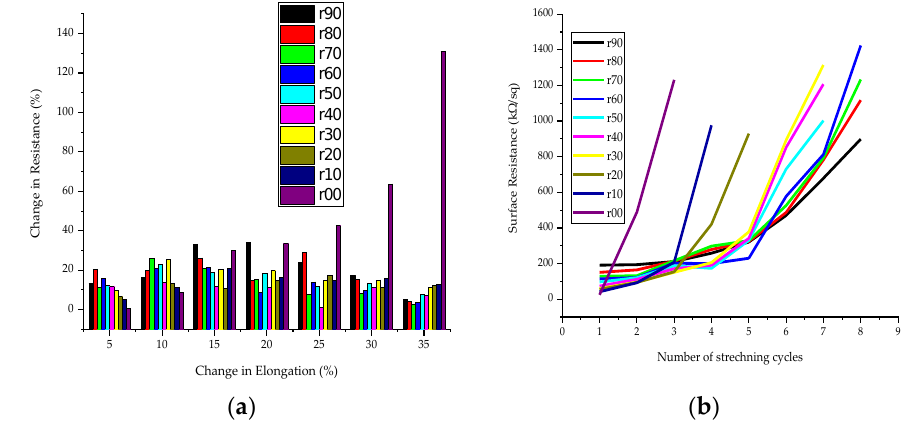
Figure 12. Effect of stretching on surface resistance and sensing stability: (a) Change in resistance due Figure 12. E ff ect of stretching on surface resistance and sensing stability: ( a ) Change in resistance due to stretching; ( b ) surface resistance at different stretching cycles. to stretching; ( b ) surface resistance at di ff erent stretching